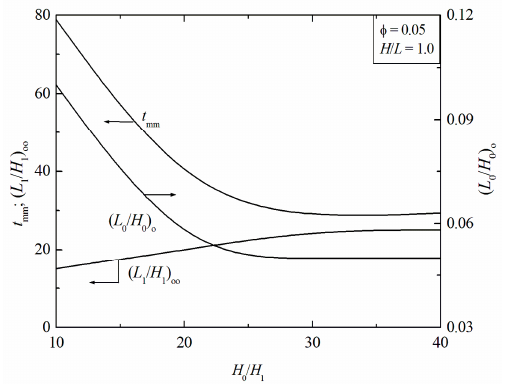
Figure 11. Effect of the ratio L 0 / H 0 for different ratios of H 0 / H 1 on ( a ) infusion time (once minimized), ( t ) m ; ( b ) ratio (once optimized), ( L 1 / H 1 ) o .